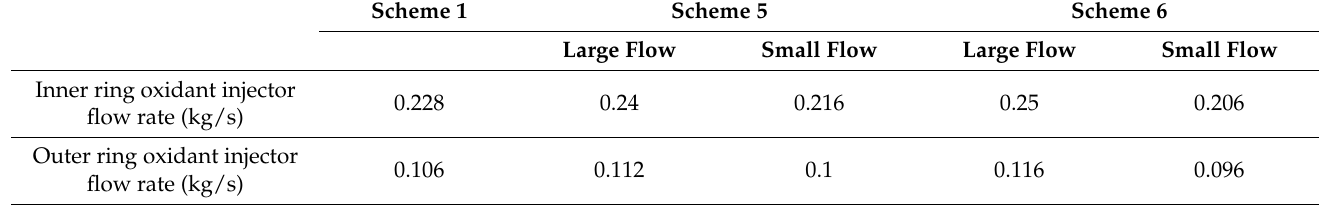
Table 3. Settings for Schemes 5 and 6.